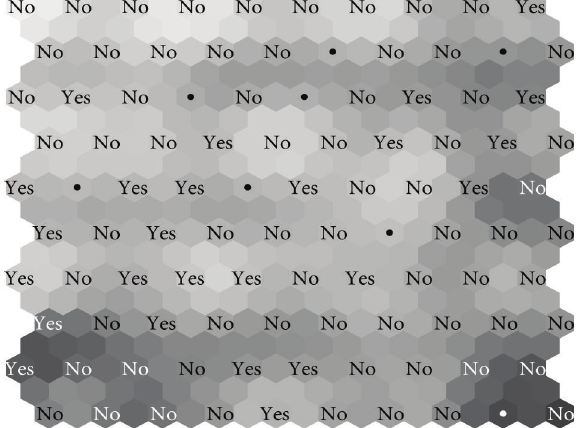
Figure 18: U-matrix for feature Information